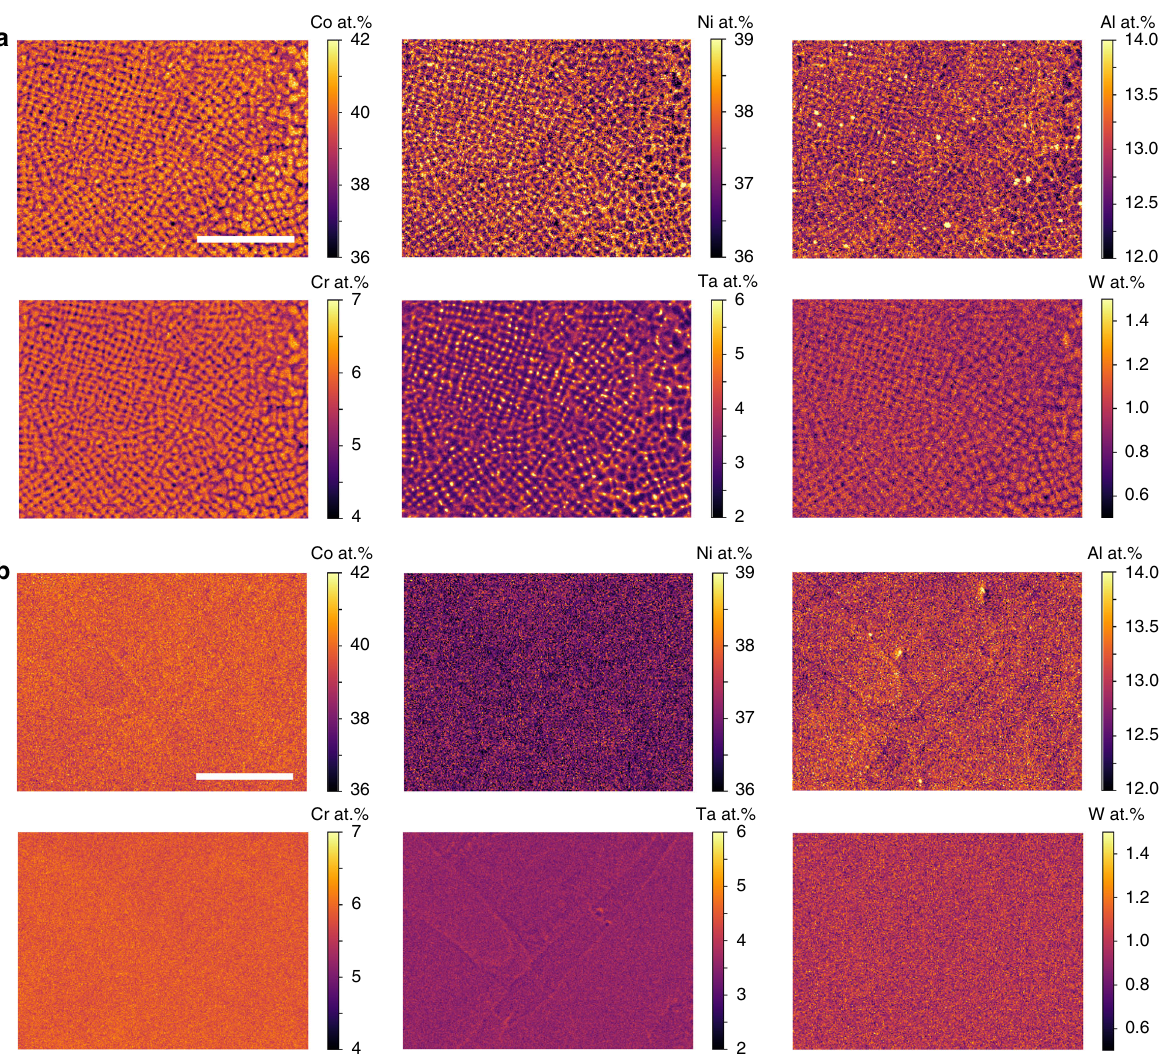
Fig. 3 Quantitative EPMA maps. EPMA elemental composition maps of the XY -plane microstructures for the a EBM and b SLM samples. Co, Cr, and W segregate to the dendrite core while Ni, Al, and Ta segregate to the interdendritic regions. Each map has a step size of 0.5 μ m. The scale bars for a and b are 100 μ